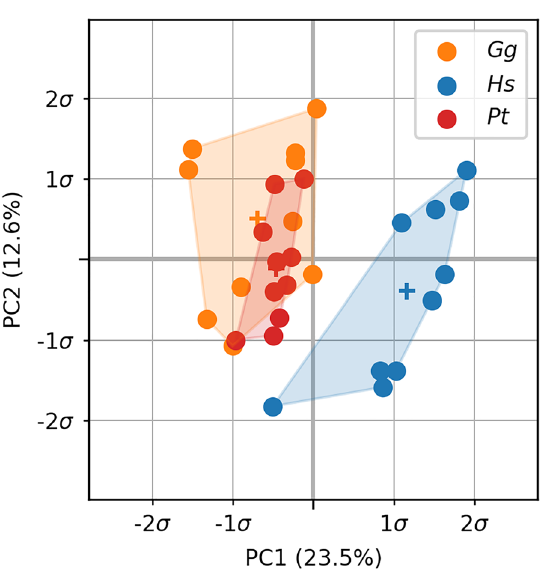
Figure 8. Thresholded femoral heads. rBVTV after thresholding at 80-percentile of each distribution in the femoral head only, shown here in three different views per species. From top to bottom: Gg Gorilla gorilla , Pt Pan troglodytes , Hs Homo sapiens . L lateral, S superior, P posterior.